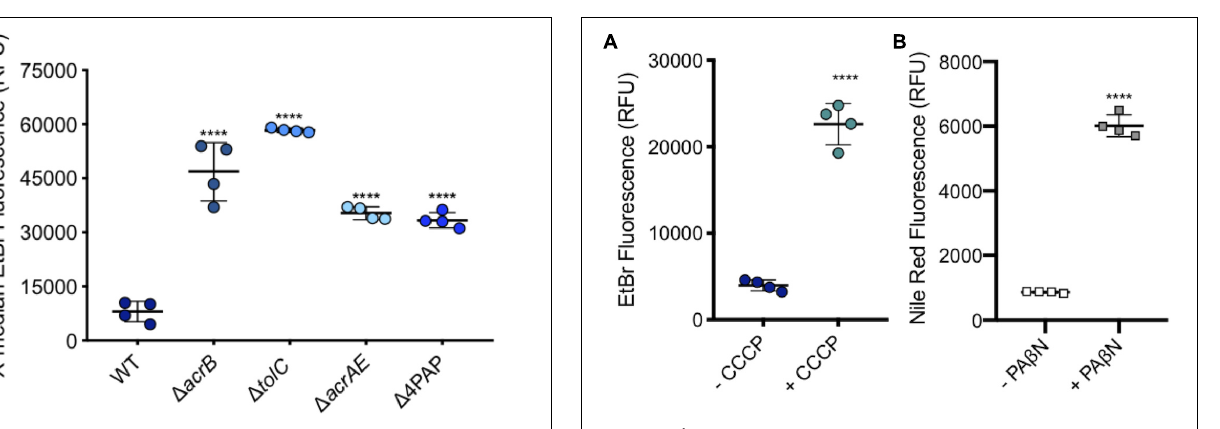
FIGURE 7 | Accumulation of ethidium bromide in SL1344 in the absence and presence of 100 µ M CCCP and 50 µ g/ml of PA β N. (A) Single dots represent the X-median value of ethidium bromide fluorescence from 10,000 cells within a biological replicate. 4 biological replicates for each condition are shown, with a long bar to show the mean and standard error of the mean (SEM) error bars. WT had a mean RFU of 3936 (blue); +CCCP (green) the RFU increased sixfold to 22596 RFU. (B) Single squares represent the X-median value of nile red fluorescence in the presence and absence of PA β N, from 10,000 cells within a biological replicate. 4 biological replicates for each condition are shown, with a long bar to show the mean and SEM error bars. WT had a mean RFU of 863 (white); + Pa β N (gray) RFU showed a sevenfold increase. For both (A) and (B) Significance values were based on an unpaired T -test. The P -values were < 0.0001 which was represented by ∗∗∗∗ in this